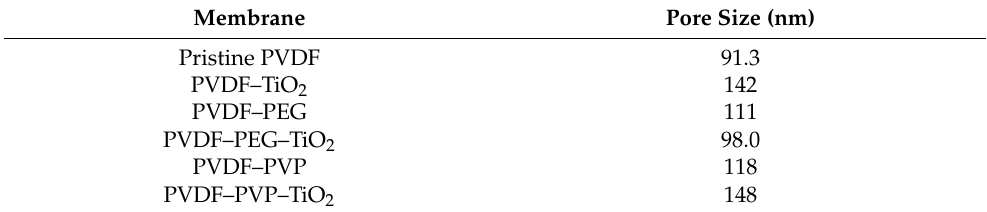
Table 2. Pore size of membranes.